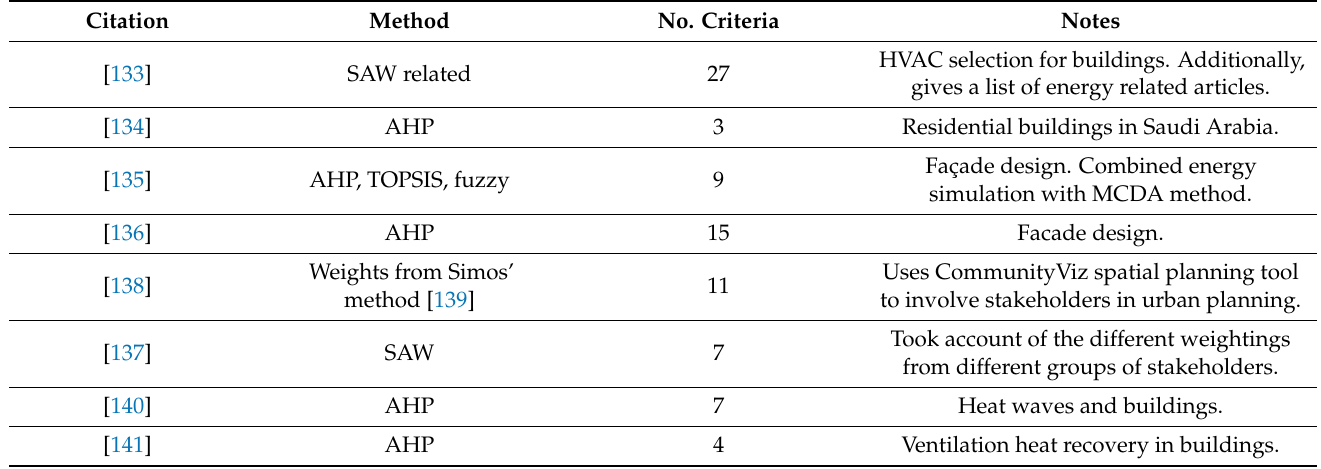
Table 12. Examples of applications of MCDA to Building energy